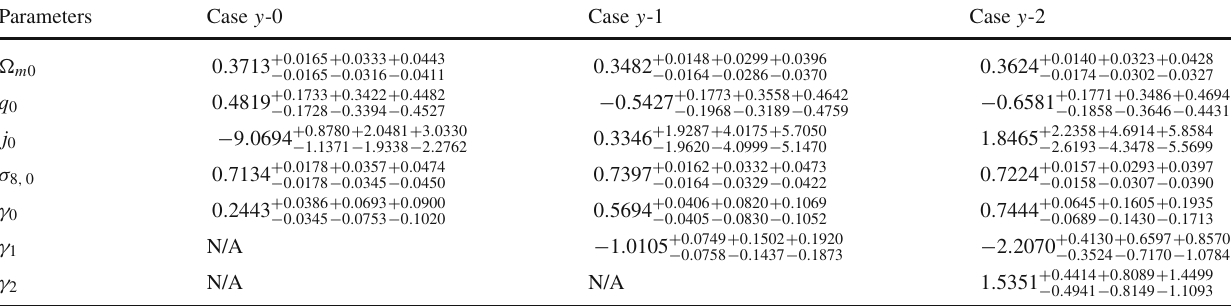
Table 3 The mean with 1 σ , 2 σ , 3 σ marginalized uncertainties of the model parameters for the cases with the y -cosmography and γ = γ 0 (labeled as “ y -0”), γ = γ 0 + γ 1 y (labeled as “ y -1”), γ = γ 0 + γ 1 y + γ 2 y 2 (labeled as “ y -2”). See the text for